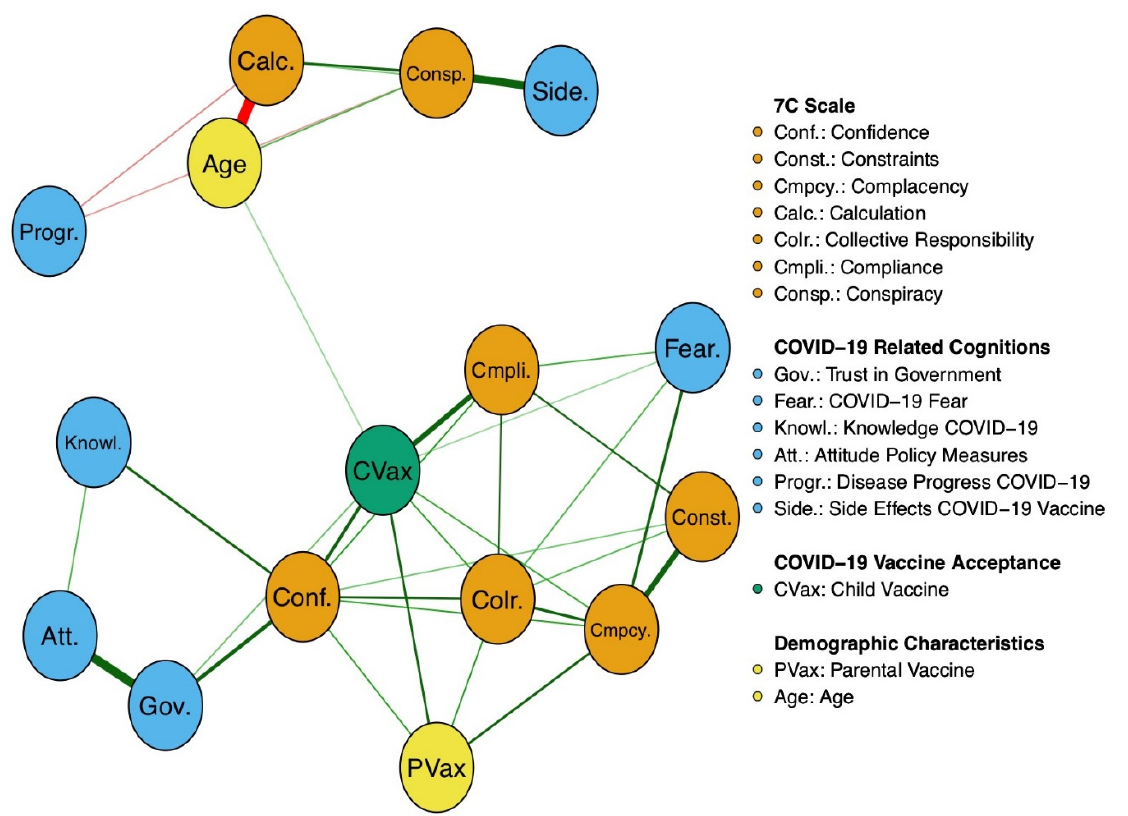
Figure 1. Visual MGM Network. The abbreviations within the network display the nodes. The connections between those nodes are referred to as edges. The thickness of the edges represents the edge weight, which is an indication of the strength of the edge. The thicker the edge, the higher the edge weight. Green edges represent positive associations, whereas red edges represent negative associations. The meanings of the variables’ abbreviations can be seen on the right side of the network display.